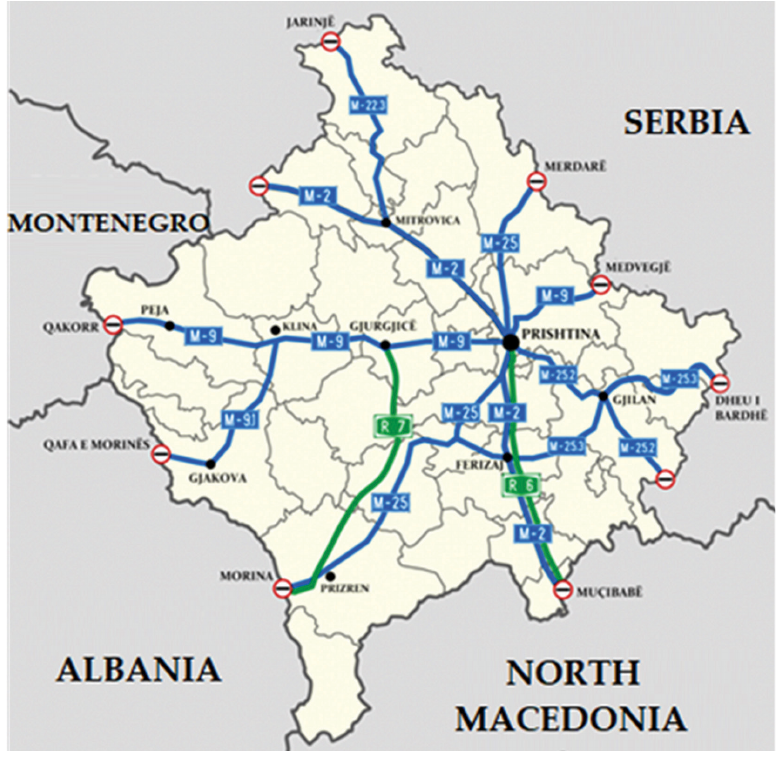
Figure 1. Map of Kosovo – study area (ICMM,